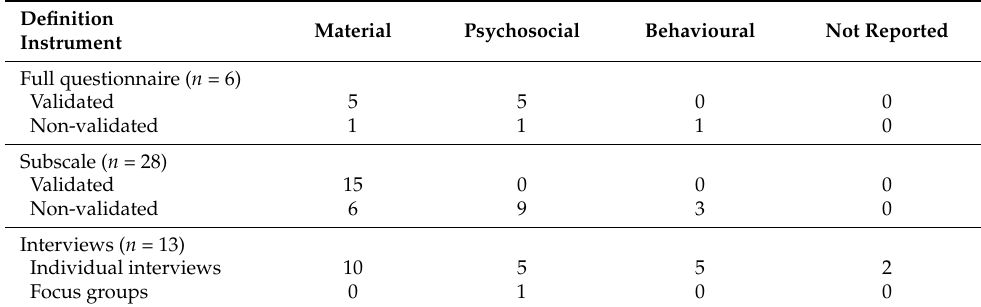
Table 2. Definition of and instruments for financial